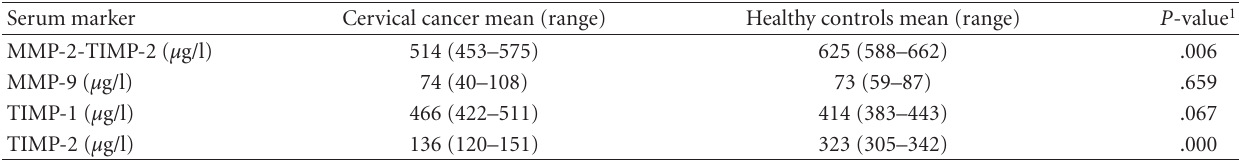
Table 1: Serum levels of MMP-2-TIMP-2 complex, MMP-9, TIMP-1, and TIMP-2 in patients with squamous cervical cancer and in healthy